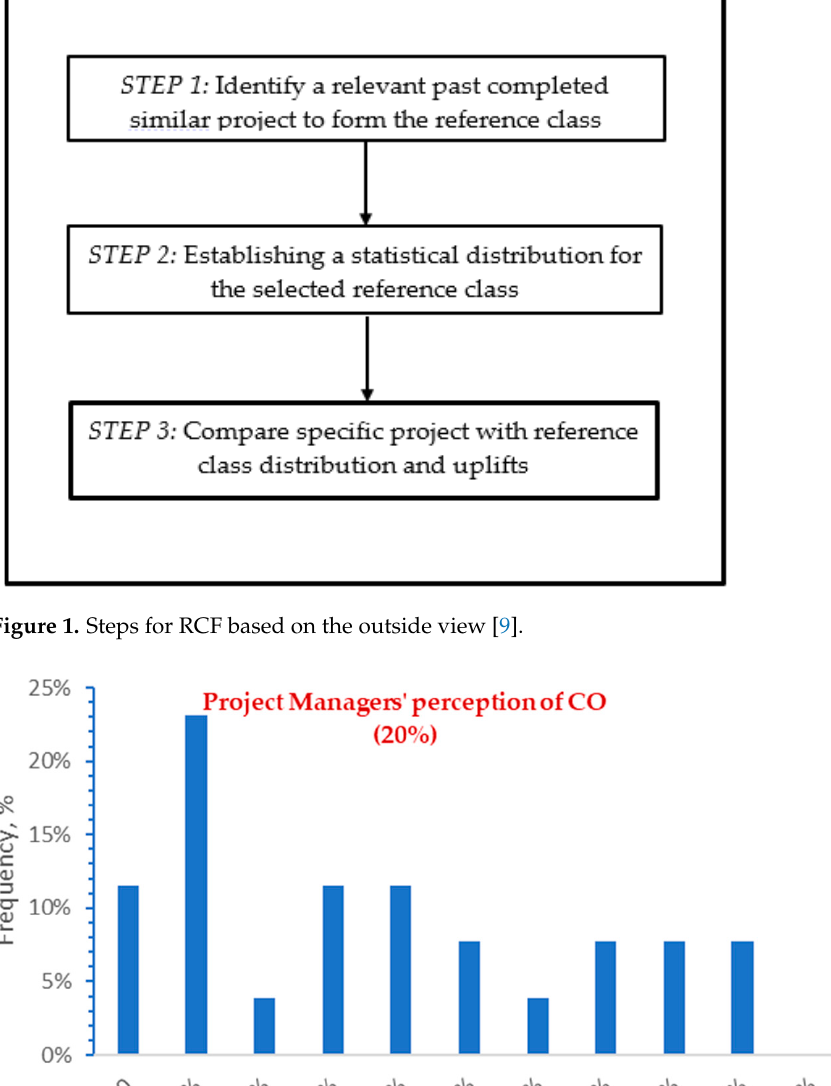
Figure 3. Normal distribution of cost overrun in PSSHPs. The curve is positively skewed, with long positive tails, indicative of high CO on PSSHPs. The mean cost overrun is 69%, with a standard deviation of 63%. The skewness was found to be 0.42, indicating that the data is fairly symmetrical ( − 0.5 ≤ x ≤ 0.5). The kurtosis of the distribution was negative ( − 1), indicating that more of the CO values are located nearer the centre of the distribution as compared to the tails. With these basic sta- tistics, a one tail t -test was administered to test the hypothesis that the mean CO on DB public housing projects is 20%. Based on the hypothesis test, there is strong evidence to